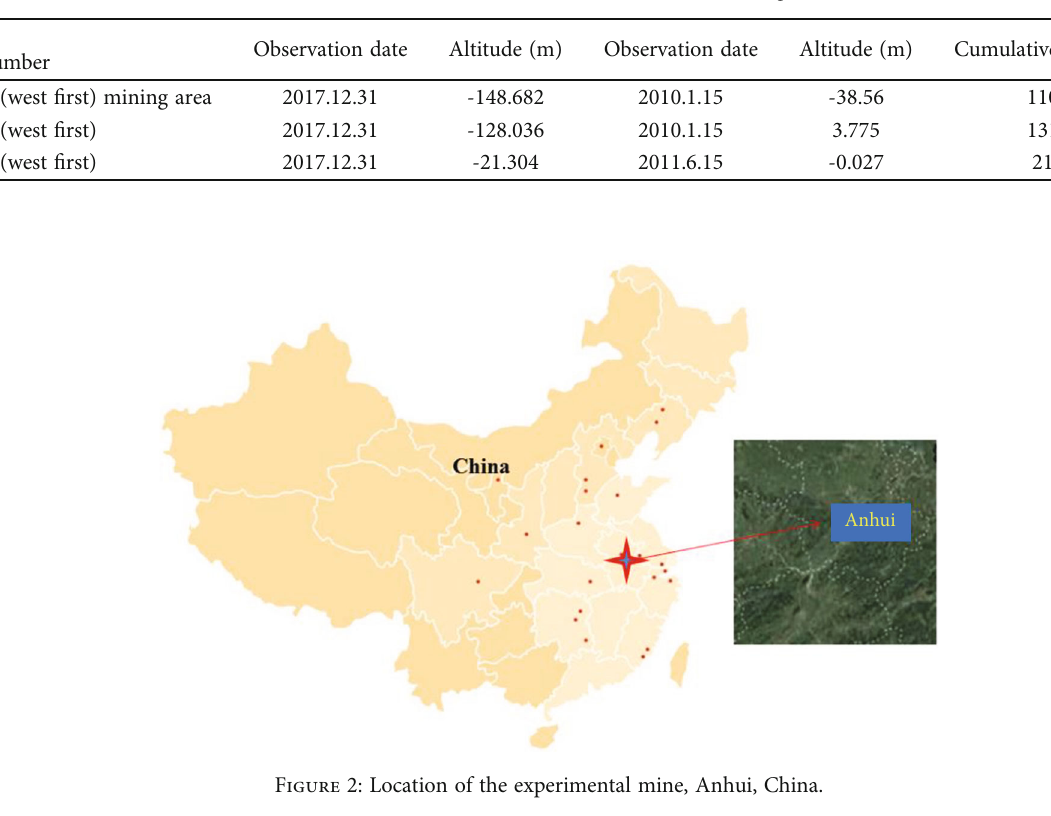
Figure 1: Number of water inrush accidents and deaths. Table 1: Statistical table of water level elevation changes.